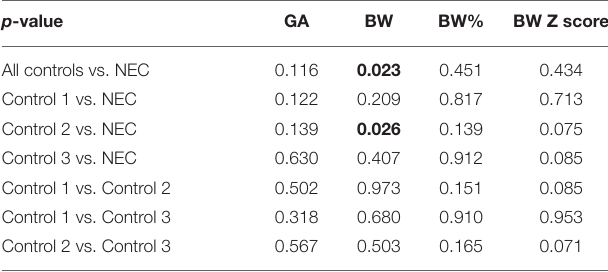
TABLE 2 | Detected statistical differences in parameters presented in Figures 4A–D . p